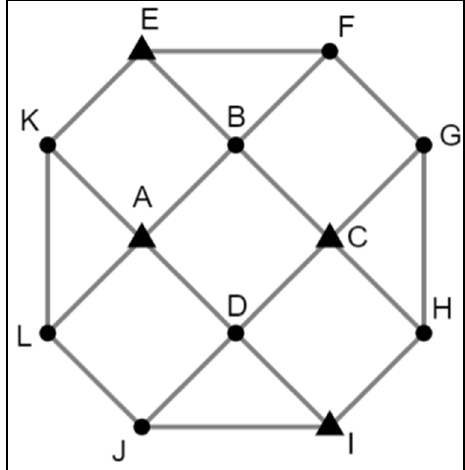
Figure 2. A representative case study.